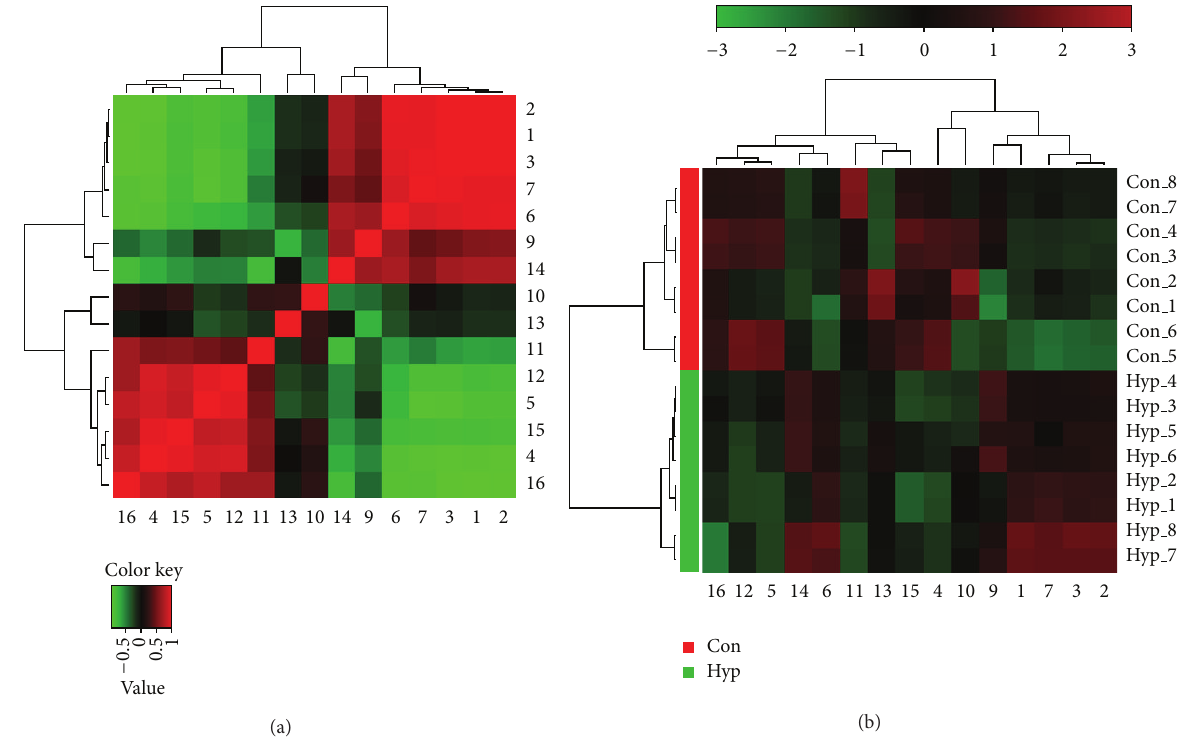
Figure 4: Correlation analysis (a) of the differential metabolites in control rats and diet-induced hyperlipidaemia rats. Heat map (b) for identified metabolites in control rats and diet-induced hyperlipidaemia rats. The color of each section is proportional to the significance of change of metabolites (red, upregulated; green, downregulated). Rows: samples; columns: metabolites. Numbers consist with Table